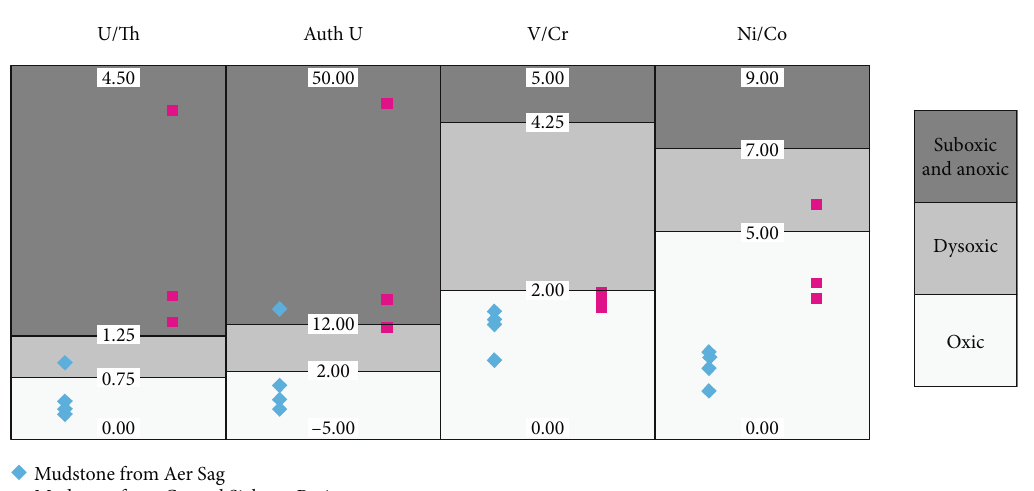
Figure 8: The PAAS-normalized plot of trace elements in the upper Ediacaran reservoir solid bitumens (PAAS from [48]).